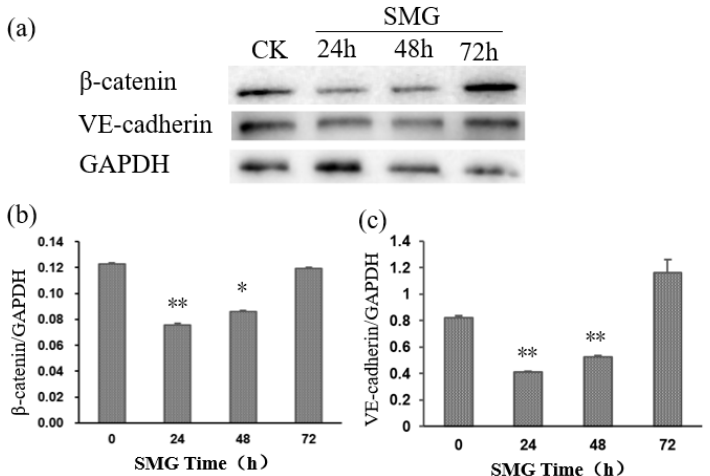
Figure 6. The expression of VE-cadherin and β -catenin was down-regulated under SMG. ( a )The total proteins were isolated from HUVEC cells treated with SMG, and expression of β -catenin and VE-cadherin protein was detected by Western blot with anti- β -catenin or anti-VE-cadherin antibody, respectively. ( b , c ) The relative expression of β -catenin and VE-cadherin under SMG for 24, 48, and 72 h was calculated based on intense assay of each band of protein. The statistical results shown represent the means ( n = 3) vs. the control group ( n = 3); * p < 0.05, ** p < 0.01.